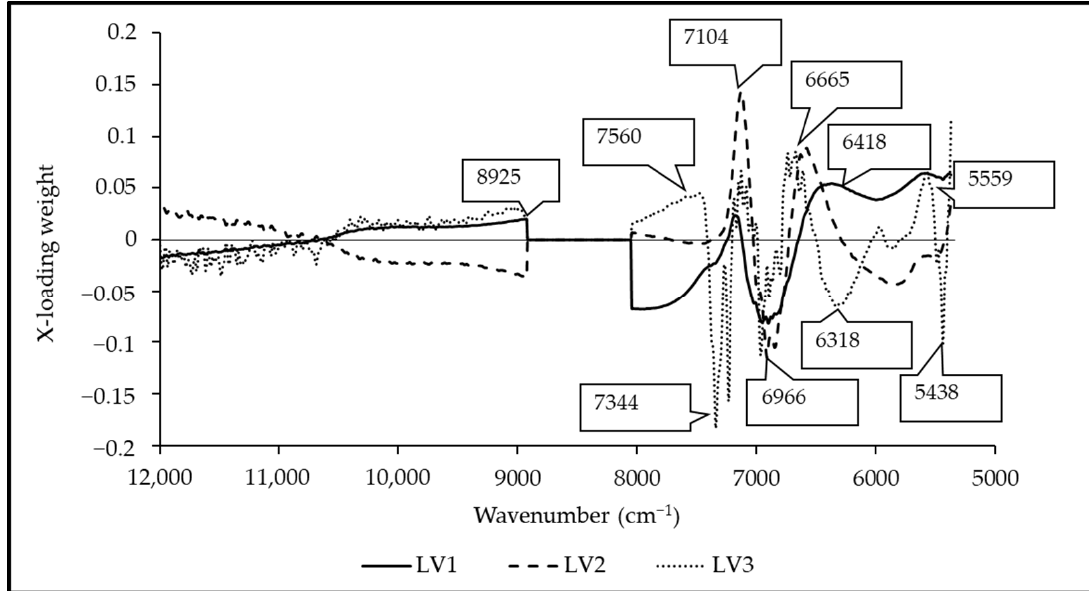
Figure 7. X ‐ loading plot of the PLSR model for TA prediction in mango purée.